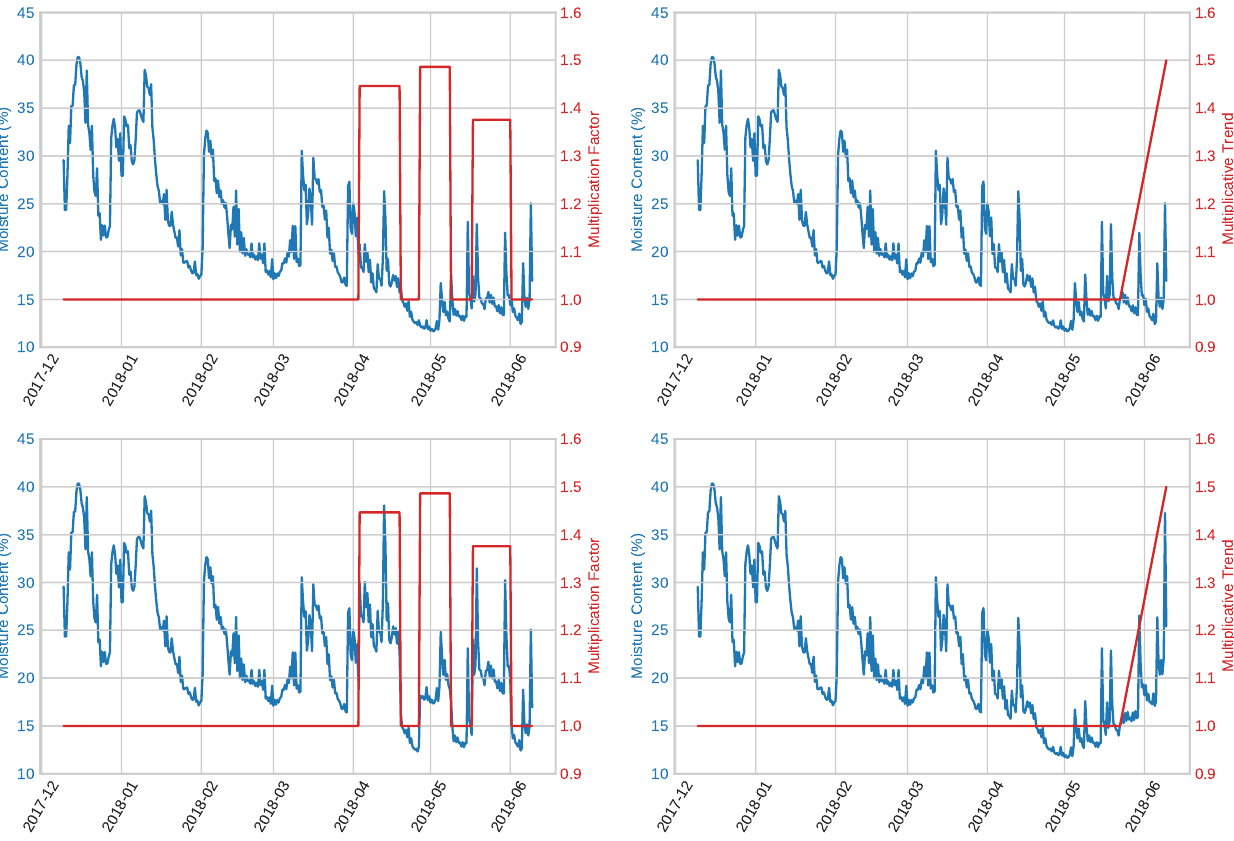
Figure 3. Examples of the application of the presented artificial anomaly generation methods: mask product ( left column ) and linear multiplicative trend ( right column ). The first row depicts the original test sequences, while the second row the resulting modified